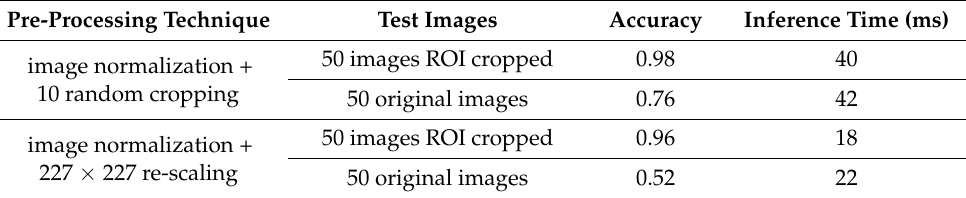
Table 5. Comparison of the random cropping influence on the classification result as a pre-processing technique.